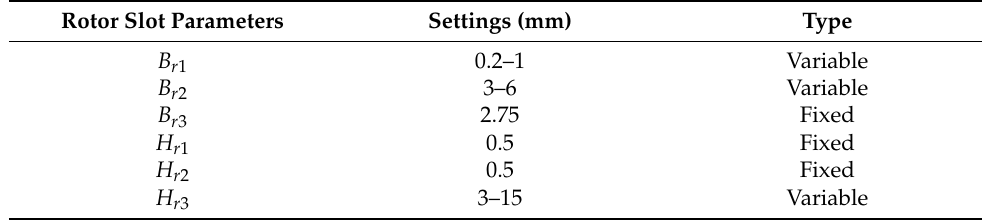
Table 4. Parameter settings of rotor slot